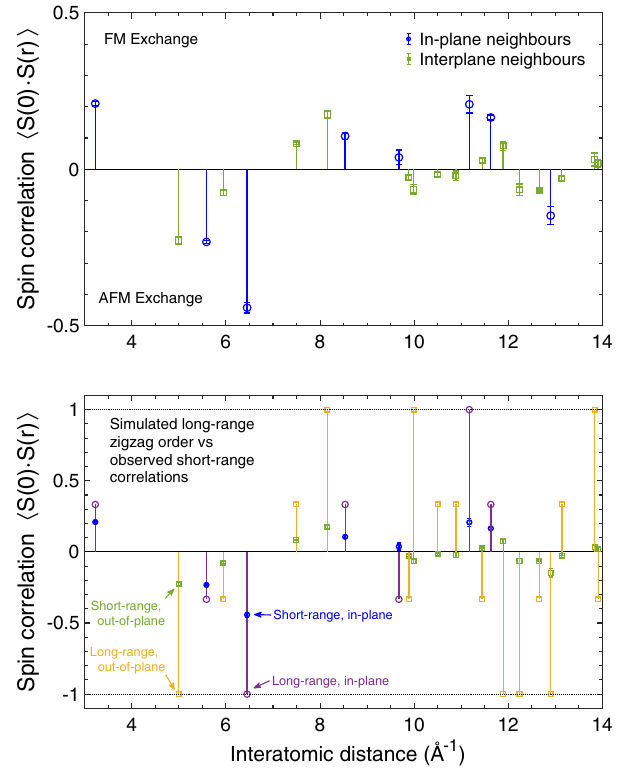
FIG. 7. Normalized spin-spin correlation function h S ð 0 Þ · S ð r Þi values for increasing interatomic distances from nearest-neighbor upward for FePS 3 at 183 kbar (upper plot). Perfect ferromagnetic correlations would give a value of þ 1 and perfect antiferromag- netic − 1 . The values shown are extracted from the reverse Monte Carlo fits to the difference plot shown in the inset in Fig. 6. Nearest-neighbor correlations are seen to be ferromag- netic, and others predominantly antiferromagnetic, similar to those in ambient-pressure FePS 3 . The simulated correlation values for such ideal long-range zigzag order with antiferromag- netic interplanar correlations are shown overlaid on the same data in the lower plot for